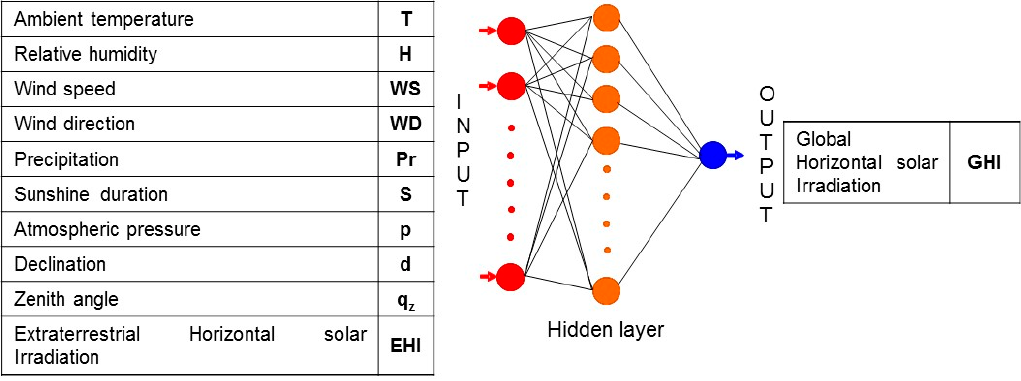
Figure 2. ANN structure for GHI estimation.